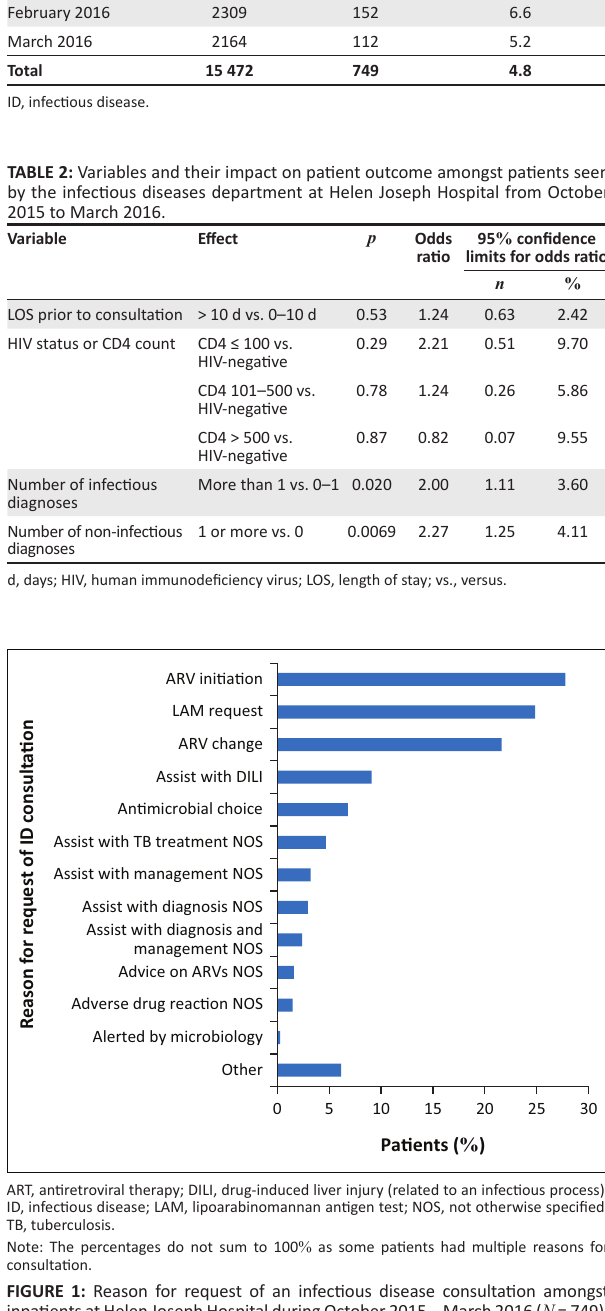
FIGURE 1: Reason for request of an infectious disease consultation amongst inpatients at Helen Joseph Hospital during October 2015 – March 2016 ( N = 749).